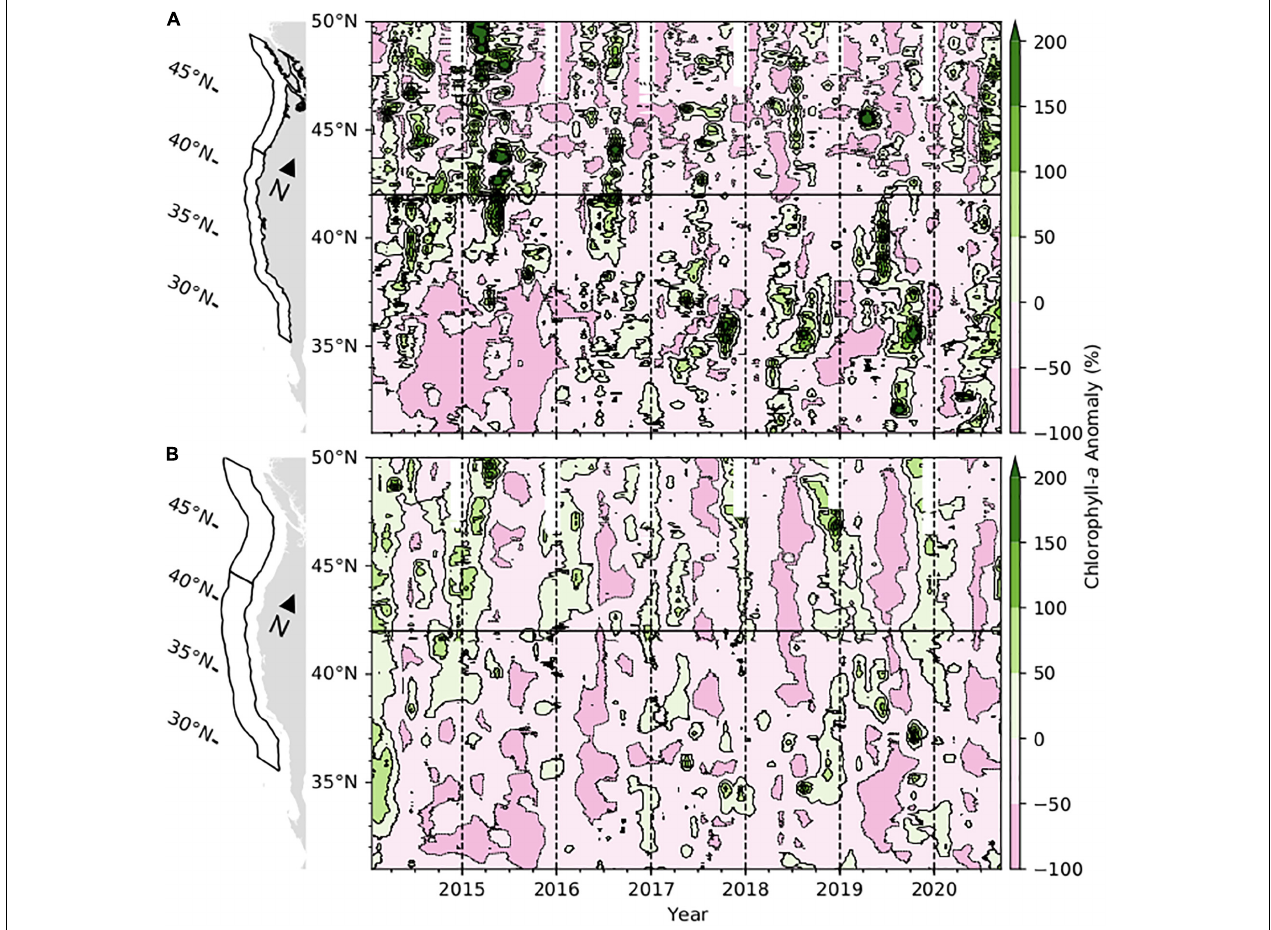
FIGURE 7 | Anomalies in monthly mean surface chlorophyll- a concentration in the CCS for the period January 2014 to September 2020 in panel (A) the coastal region 0–100 km from the coast, and (B) the transition zone, 100–300 km from the coast. Data in the range of 31–42 ◦ N, below the horizontal black line, are from the merged multisensor dataset described by Kahru et al. (2012) with anomalies calculated relative to the 1996–2020 mean. Data in the range of 42–50 ◦ N are from the Aqua MODIS, NPP, L3SMI, Global, 4 km, Science Quality data set with anomalies calculated relative to the 2003–2020